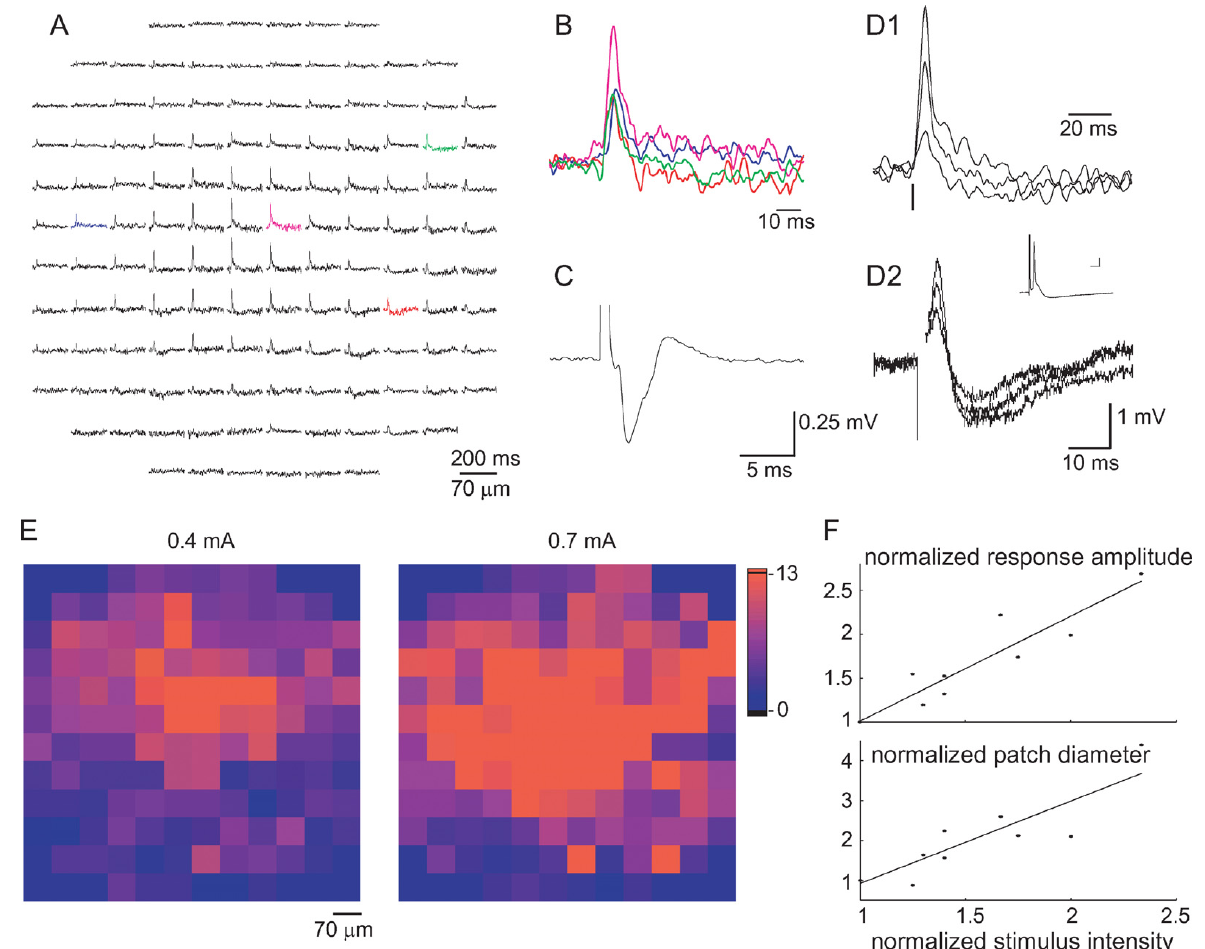
Figure 4. Characterization of mossy fiber responses. ( A ) An optical response measured by the photodiode array that has been classified as a MF response. The response is spatially organized in a radial patch in which inhibition is evident mainly in the periphery. ( B ) Four superimposed traces from the colored diodes in A displayed in an enlarged scale, demonstrating the time course of the response. ( C ) A MF evoked field potential. ( D ) Comparison between optical responses (D1) to responses recorded intracellularly from a PC (D2) to three stimulus intensities. Inset in D2 shows a suprathreshold stimulus that evoked a simple spike (scales 5ms and 5mV). Note the difference in the duration of the hyperpolarized phase of the response. Vertical lines mark stimulus time. ( E ) Responses to 0.4 and 0.7mA stimulation presented in a color code of the signal to noise ratio. The color in the location of each diode corresponds to the response amplitude divided by the standard deviation of the noise in the specific diode. ( F ) Response amplitude (upper panel) and the diameter of the responding patch (lower panel) are plotted against stimulus intensity. The diameter is defined as the average of the two eigenvalues. Data pooled from five experiments and normalized to the values corresponding to the lowest stimulus intensity are used in each